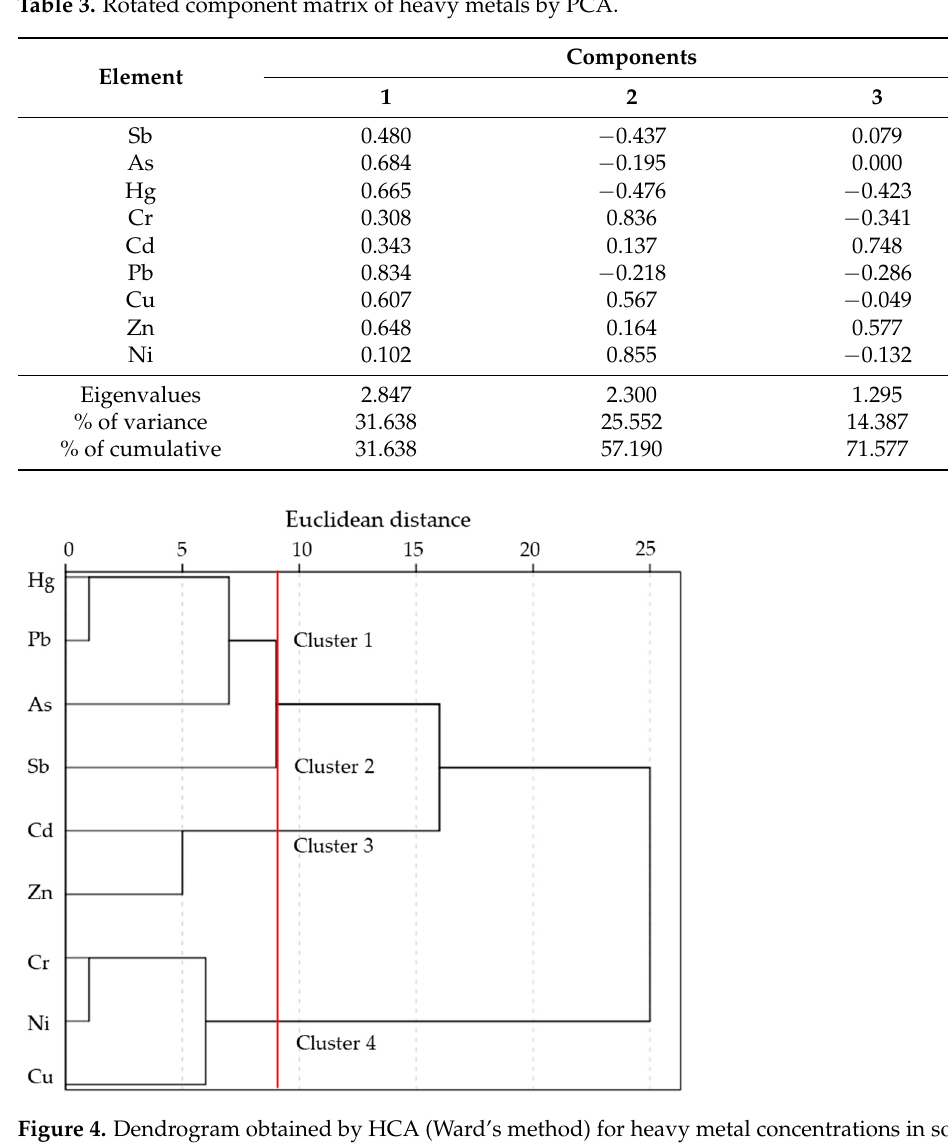
Figure 4. Dendrogram obtained by HCA (Ward’s method) for heavy metal concentrations in soils of the study area.